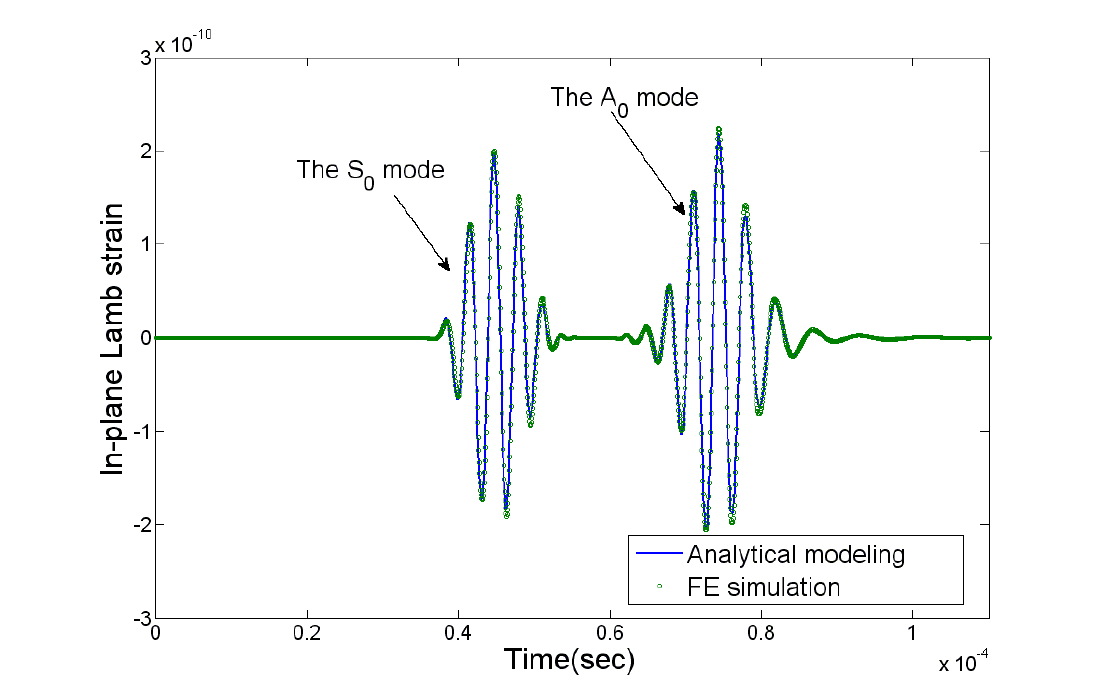
Figure 7. The comparison of the resulting Lamb waves predicted by the integral model [50] and the finite element